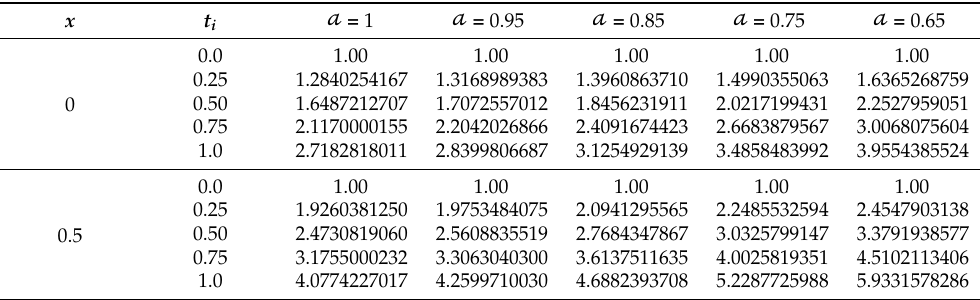
Table 1. Results of the 10-th approximate solution at different values of